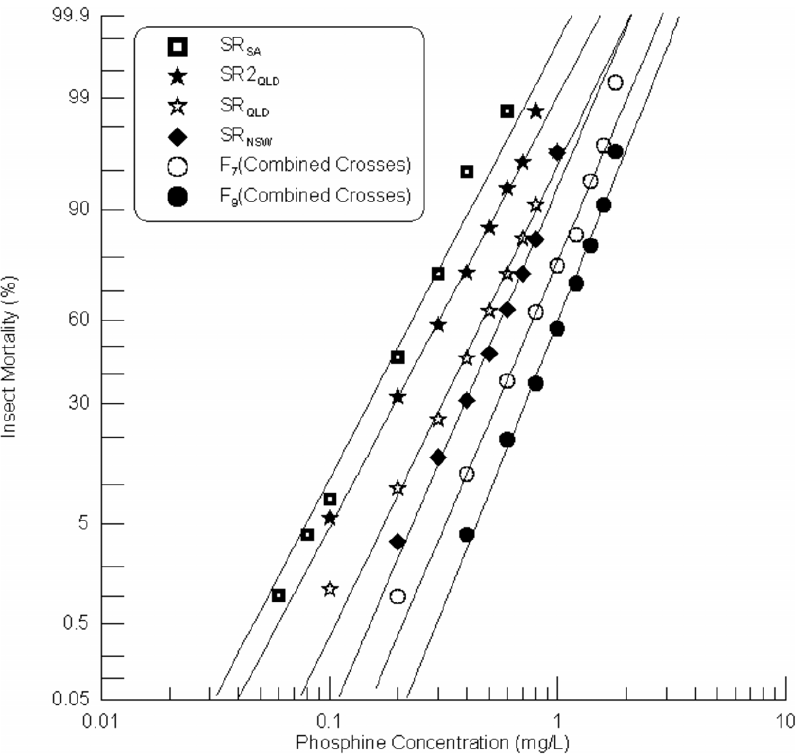
Figure 8. Resistance response of selected F 7 and F 9 progenies of a pooled hybrid (combined crosses) progeny of two single crosses between the strong resistant R.dominica strains, SR QLD 6 SR SA and SR NSW 6 SR2 QLD . Results are presented as log-dose mortality of the F 7 and the F 9 progenies with reference curves of the parental strains, SR QLD , SR2 QLD , SR NSW and SRSA. Phosphine exposure was for 48 hours at 25 u C and 70% r.h.